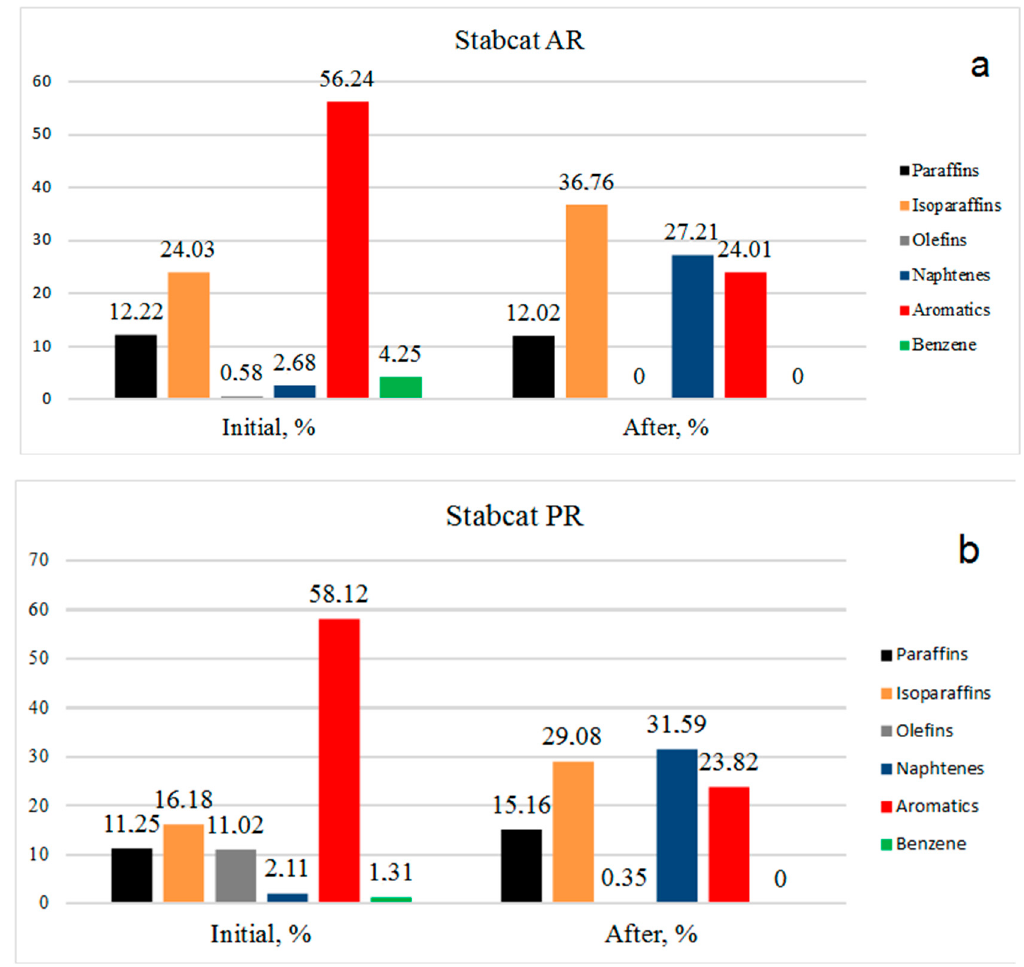
Figure 2. Group composition of gasoline fractions over Rh-Pt/ γ -Al 2 O 3 : ( a ) Stable catalysate AR, ( b ) stable catalysate PR.